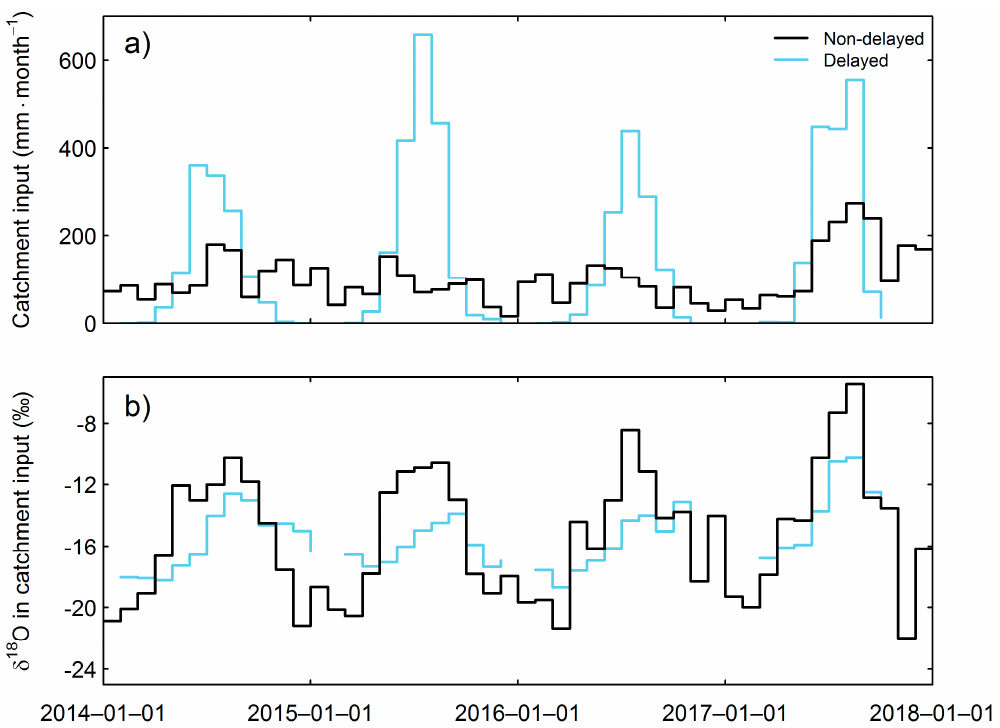
Figure 3. ( a ) Monthly water input into the catchment, and ( b ) its respective δ 18 O value during the period 2014 to 2017. The non-delayed input represents precipitation, i.e., the sum of snow